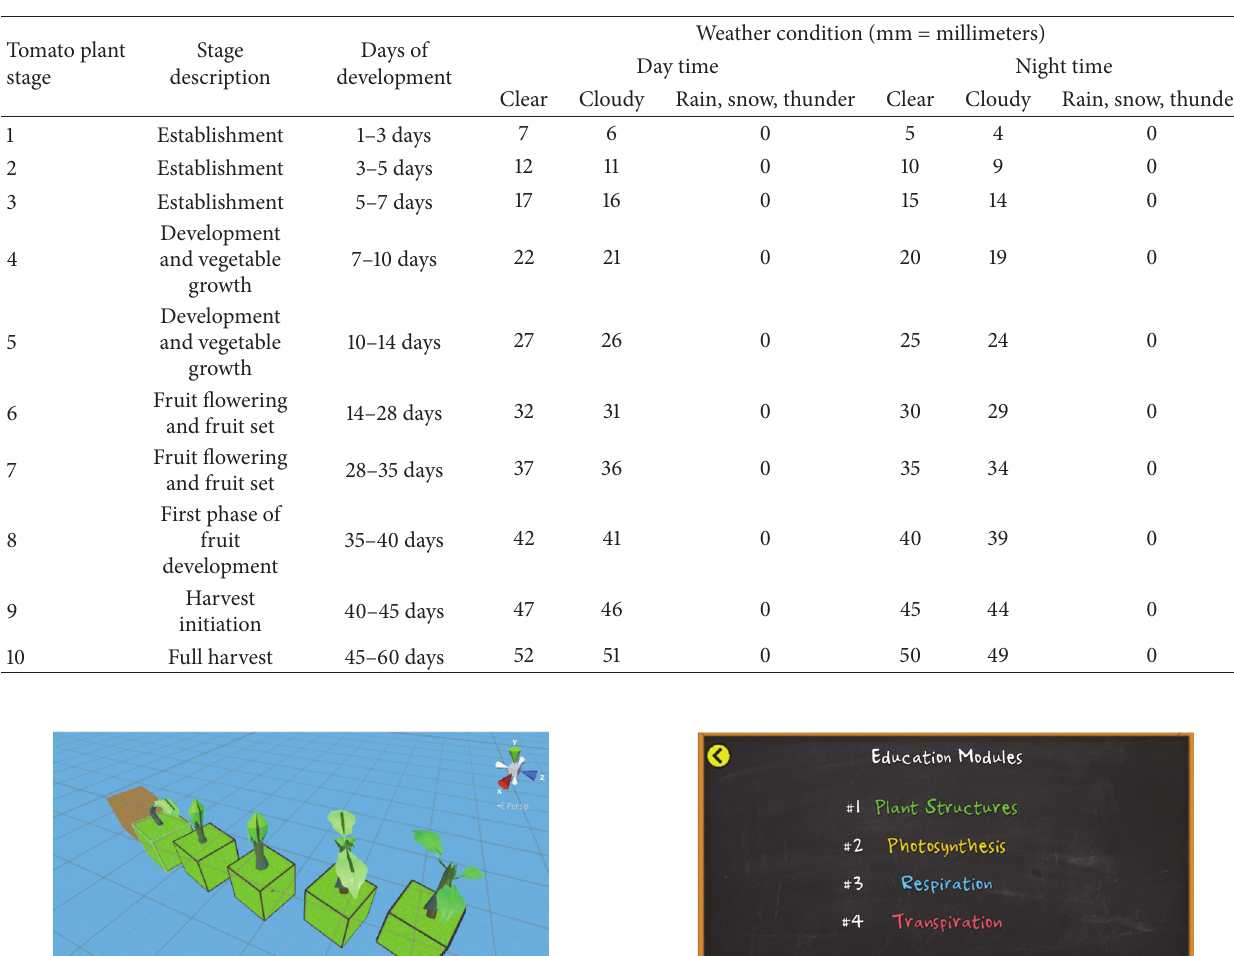
Table 3: Water amount based upon tomato stages and weather conditions.